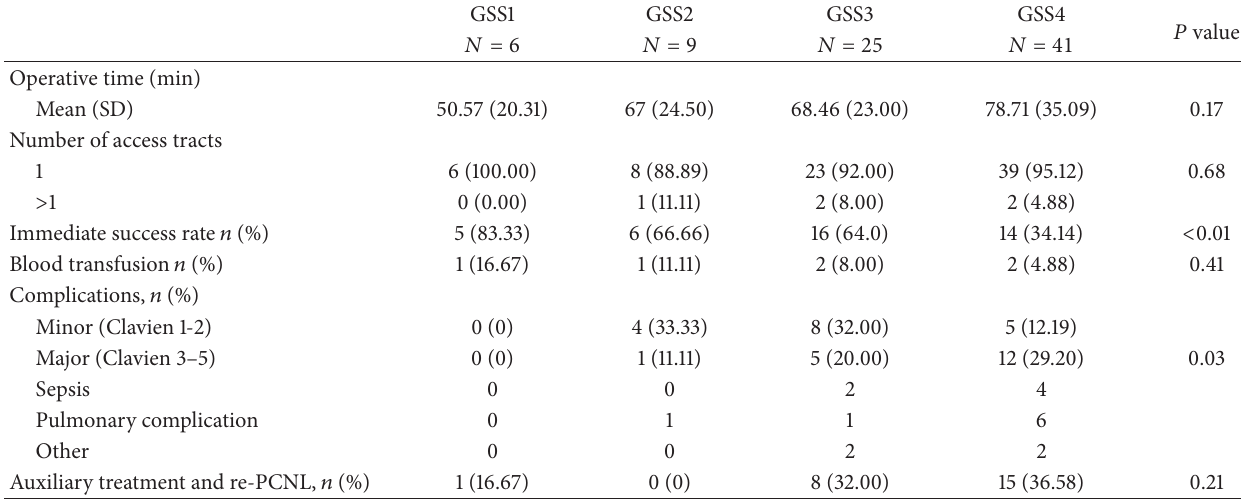
Table 4: Outcomes of supracostal upper pole access operations ( 𝑁 = 81